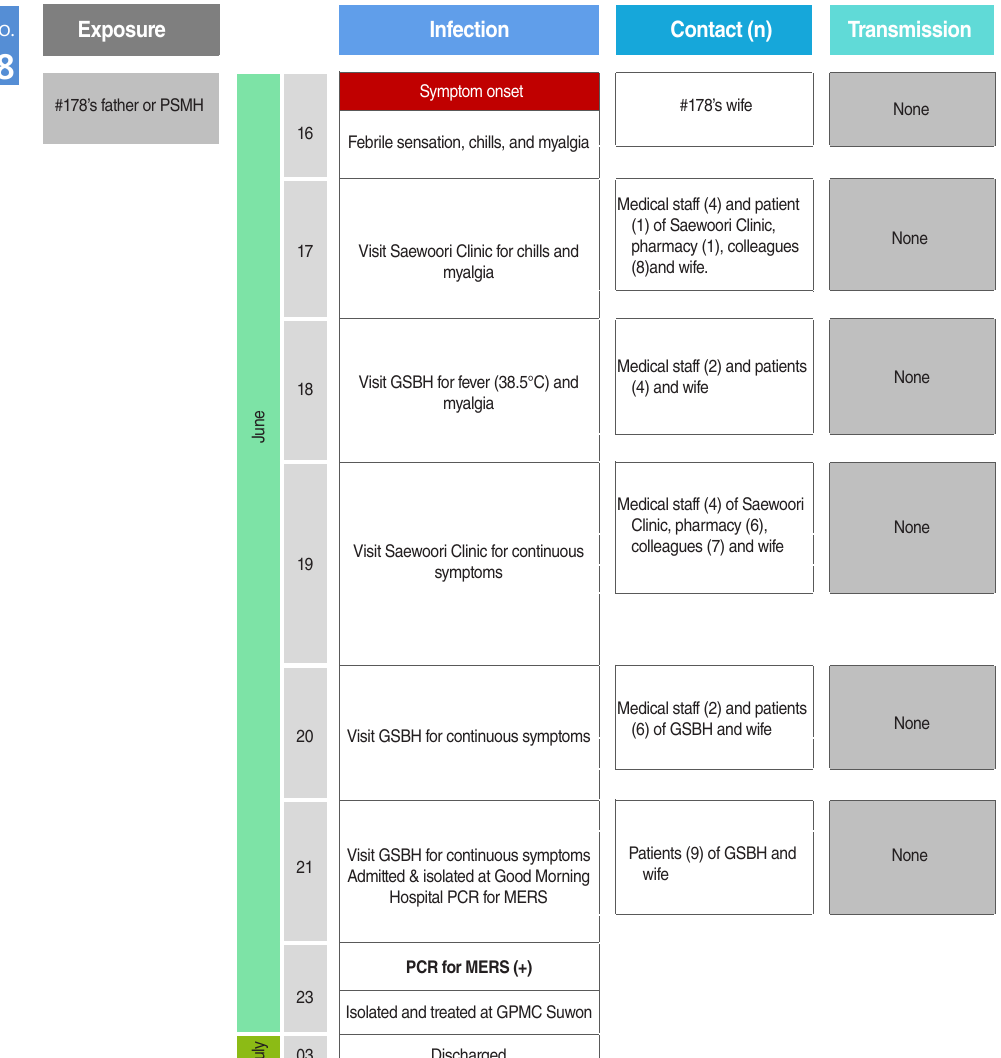
Figure 1. Main events by date for the 178th MERS case in Korea